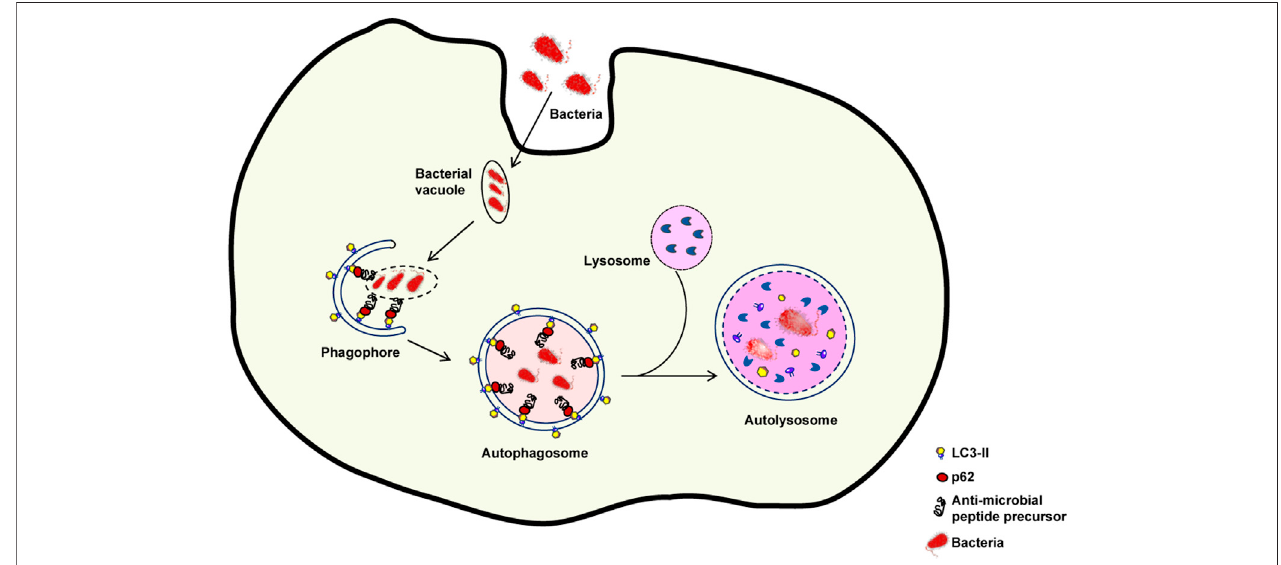
FIGURE 3 | Xenophagy: An intracellular defence mechanism against bacteria. Following host cell invasion, vacuoles harboring intracellular bacteria merge with autophagosomes and engage the autophagy machinery to kill the pathogenes in autolysosomes. However, several bacteria have developed mechanisms to escape xenophagy.Forexample,somebacteriaareabletodecreasethefusionofbacteria-containingvacuoleswithautophagosomesorofautophagosomeswithlysosomes.If the autophagic process is inhibited, bacterial reproduction can